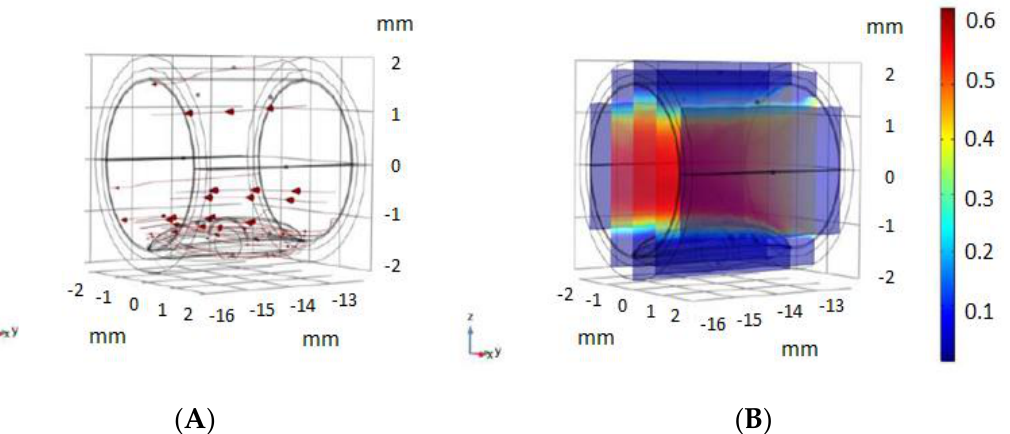
Figure 3. Blood movement model used. ( A ) blood flow movement vectors, using the Laminar Flow Analysis module of COMSOL. ( B) Velocity magnitude of blood flow (m/s) used in our model, with the conditions used in different models [14,15].